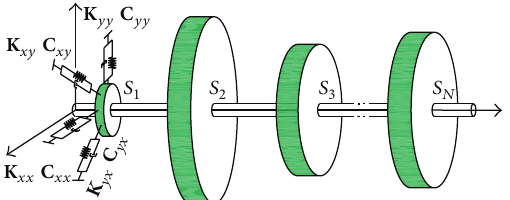
Figure 1: Multidegrees of freedom of rotor-bearing